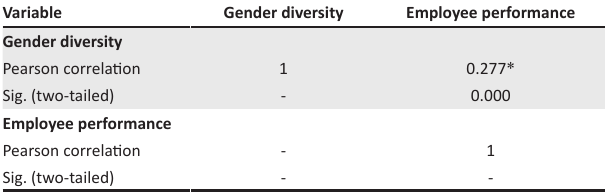
TABLE 7: The relationship between ethnic diversity and employee